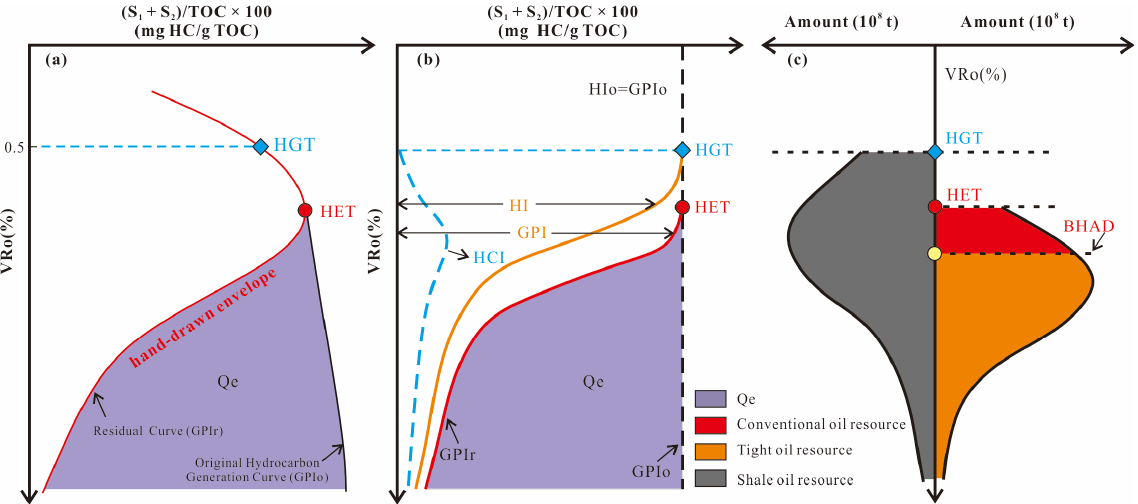
Figure 3. ( a ) Conceptual HGE model established by the traditional method proposed by Pang et al. ( a ) Conceptual HGE model established by the traditional method proposed by [12]. ( b ) The optimized HGE model established by the data ‐ driven approach. ( c ) The unified evalu ‐ Pang et al. [12]. ( b ) The optimized HGE model established by the data-driven approach. ( c ) The ation model for different hydrocarbon resources. unified evaluation model for different hydrocarbon